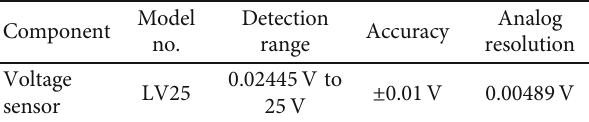
Table 1: Speci fi cations of voltage sensing